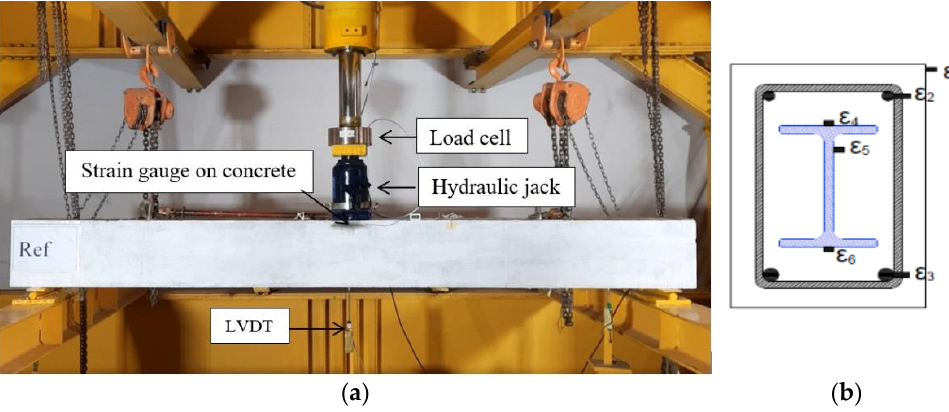
Figure 4. Experimental setup and instrumentations. ( a ) Test set-up. ( b ) Strain gauges.